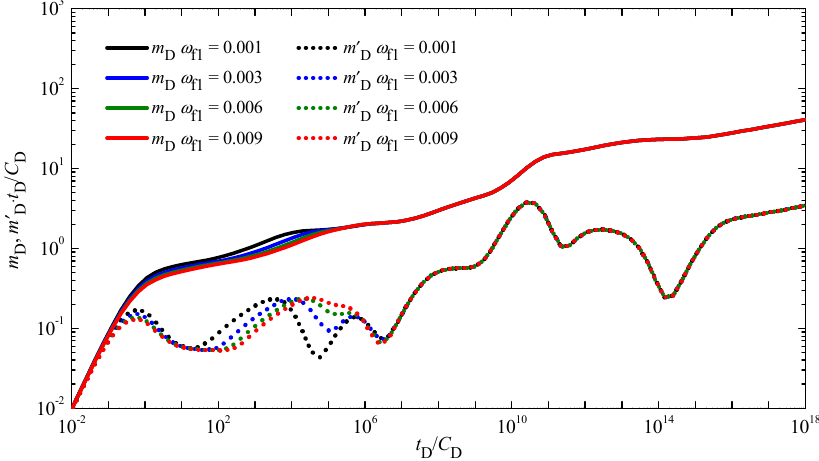
Figure 8. Influence of the inner–zone fracture storage ratio on the pressure type curve. The influence of the matrix storage ratio of the outer zone ( ω m2 ) (Figure 9) on the derivative curve was most mirrored in stage 9 to stage 12. Similarly, the effect of the matrix storage ratio of the inner zone ( ω m1 ) on the pressure derivative type curve mainly acted on stage 5 to stage 7. With the decrease in ω m2 , the first “dip” became deeper and wider, while the second “dip” became shallower and narrower (the dotted lines), and the position of the pressure decreased (the solid lines). The feature of the matrix storage ratio on the pressure curve was the opposite of that the feature of the fracture storage ratio on the pressure type curve. When the cave storage ratio is constant, the larger matrix storage ratio will cause a smaller fracture storage ratio, so they had the opposite effect on the type curve.